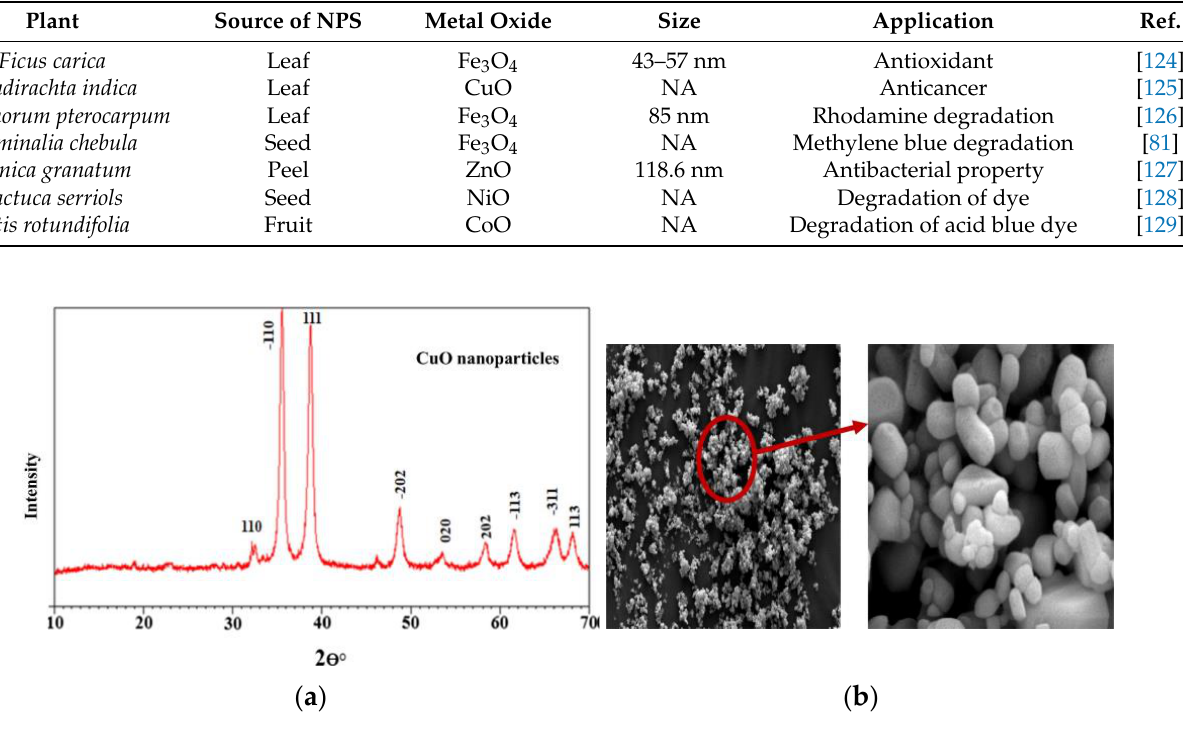
Figure 11. ( a ) XRD patterns of CuO NPs. ( b ) SEM images of obtained Cu NPs. Reprinted with permission from Ref. [123]. Copyright 2022 Elsevier .